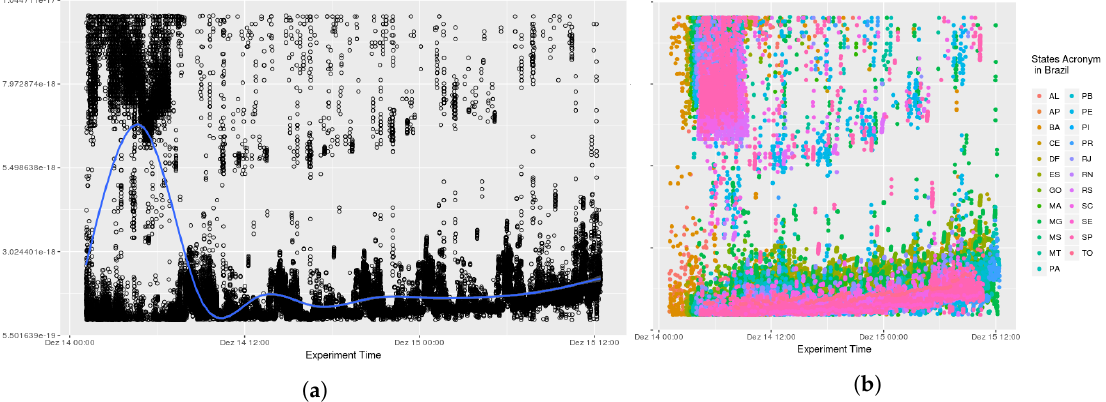
Figure 11. Scenario 03—Processing Time. ( a ) Stations in the whole country of Brazil; ( b ) Stations grouped by